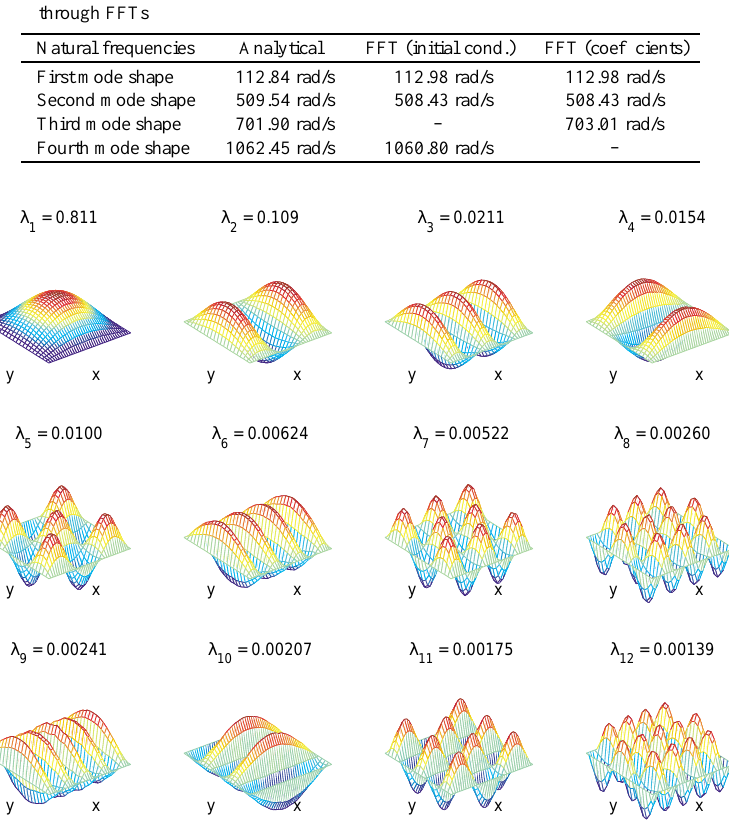
Table 1 Comparison between the truss natural frequencies obtained analytically and